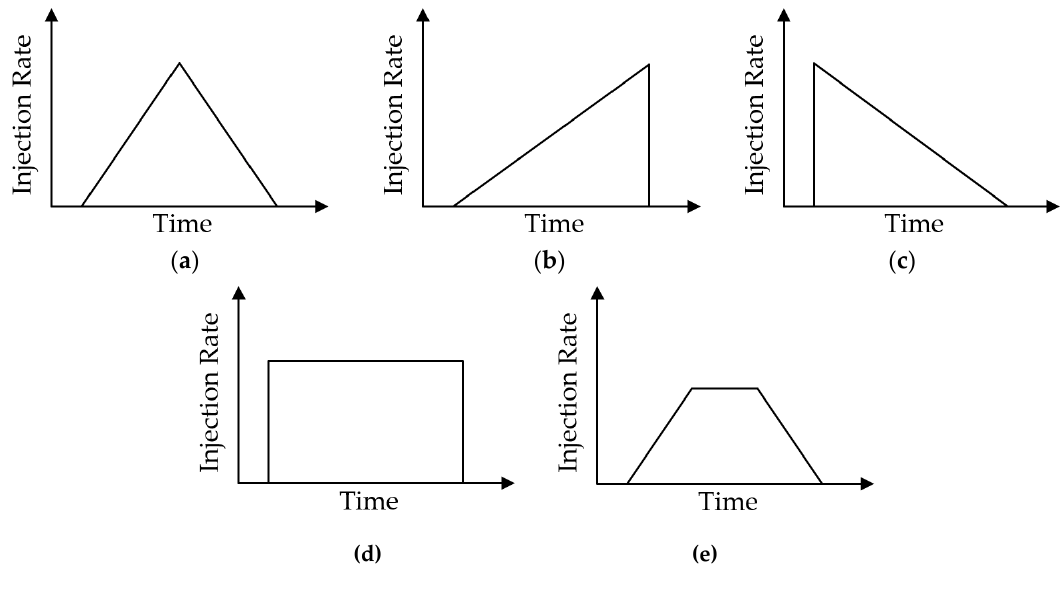
Figure 4. Schematic diagram of five injection rate shapes: ( a ) Triangle; ( b ) Ramping-up; ( c ) Ramping-down; ( d ) Rectangle; ( e ) Trapezoid.